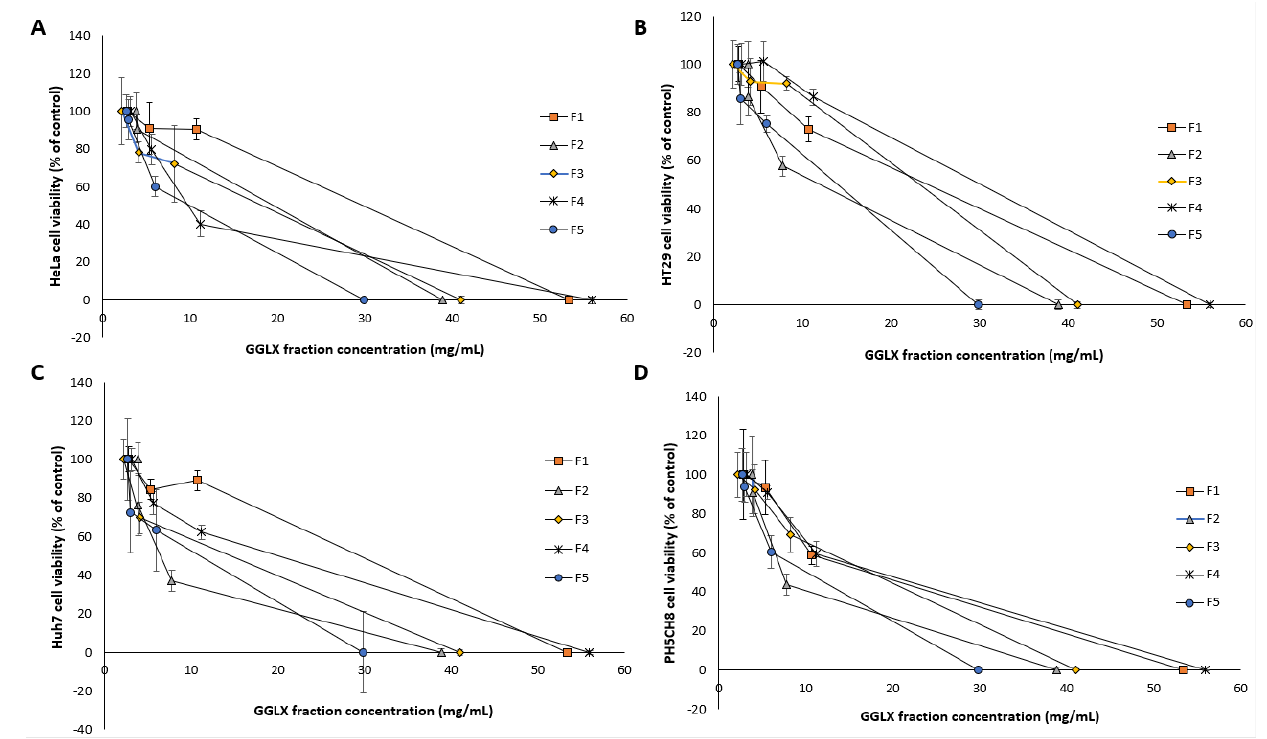
Figure 9. HPLC chromatogram of P. angustifolium and retention times at which fractions were col- lected.